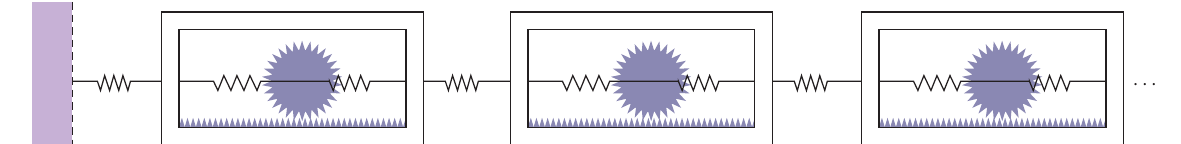
Figure 1: A schematic of the metamaterial arrangement of the 1DOF model.